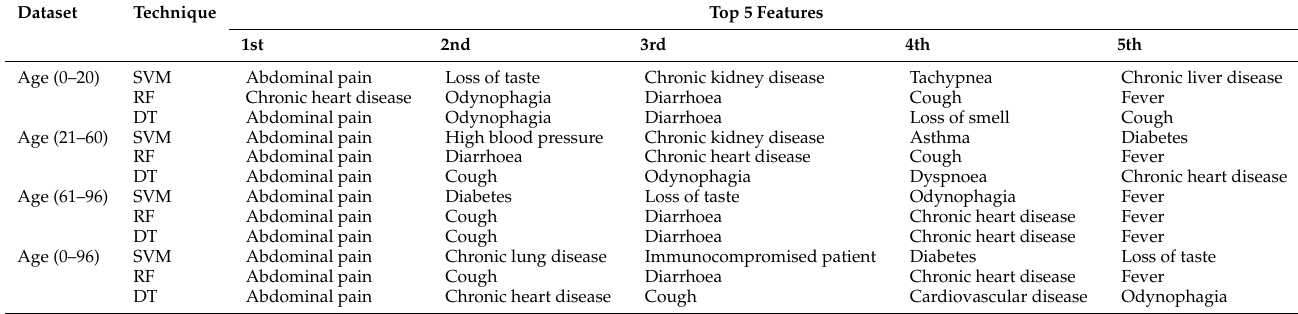
Table 3. Top 5 features reported by SVM, RF and DT techniques categorized by age